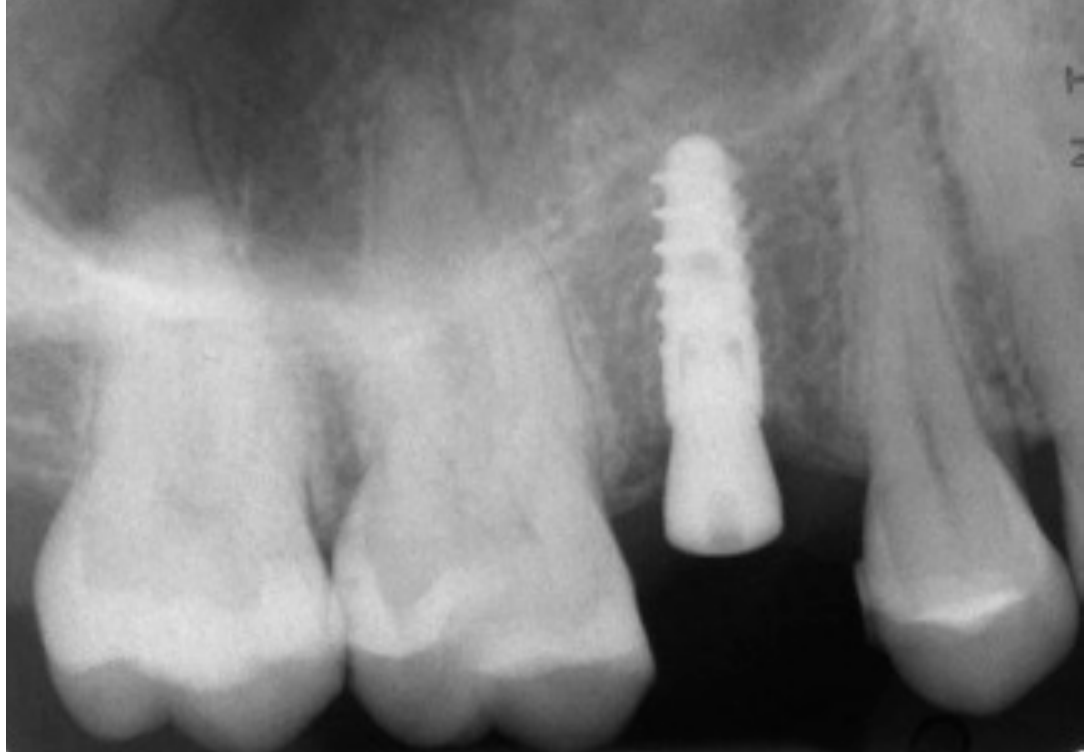
Figure 10. Post-surgical rx control of the implant and healing abutment.